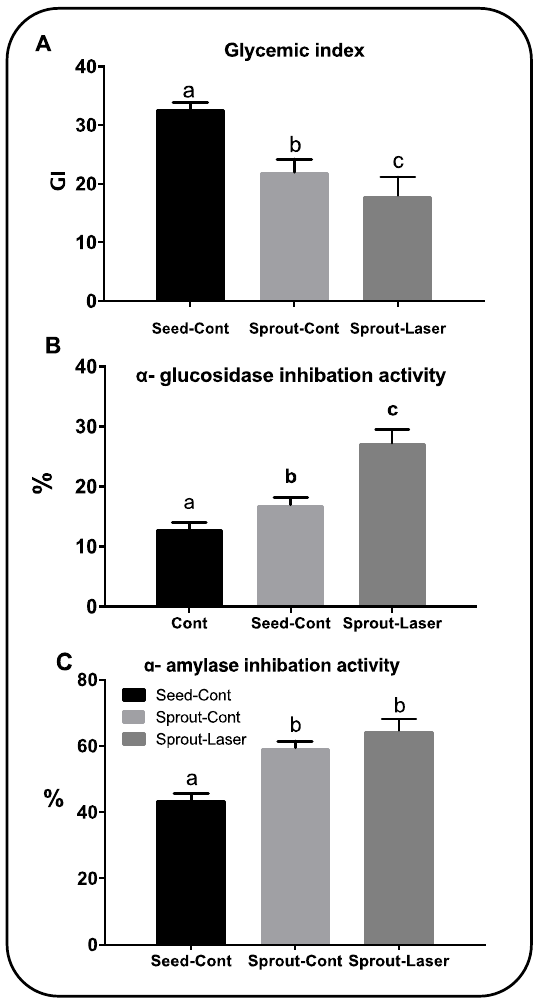
Figure 3. Effect of He-Ne laser light treatment on the anti-diabetic activity of Cymbopogon proximus sprouts and seeds. ( A ) glycemic index; ( B ) α-glucosidase inhibition activity; ( C ) α-amylase inhibition actrivity. Data are represented by means ± standard errors. Different small letters (a, b, c) above bars indicate significant differences between means at p < 0.05.